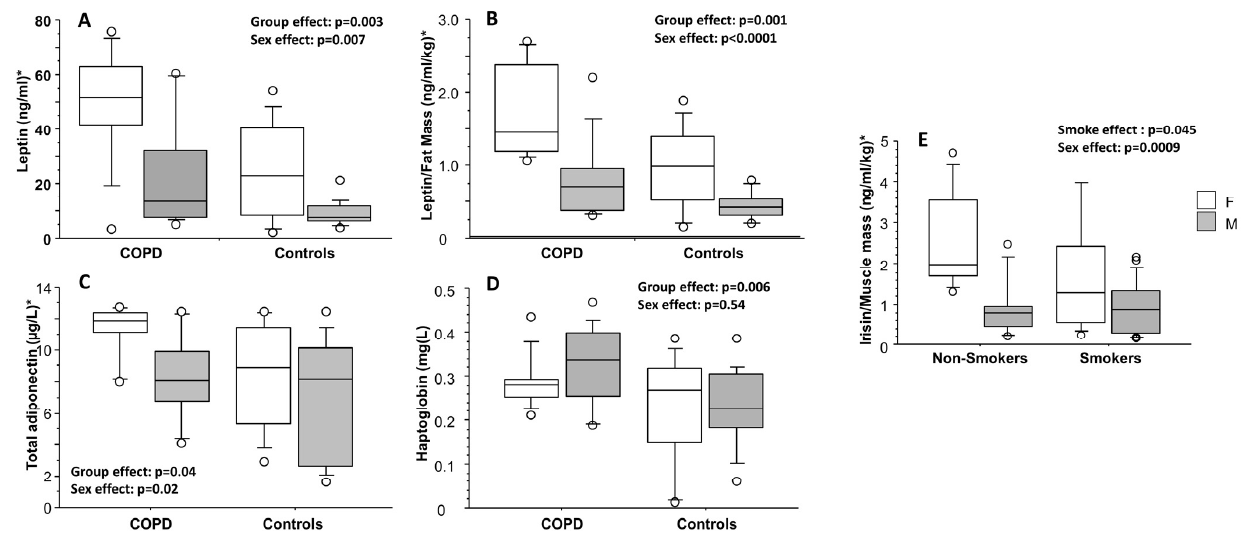
Figure 3. Leptin ( A ), leptin/fat mass ratio ( B ), total adiponectin ( C ), and haptoglobin ( D ) values, separately for COPD and control groups and sex. Irisin/muscle mass ratio ( E ), separately for smoking habit and sex. Results from two-way analysis of variance. For each box plot, from the bottom to the top, horizontal lines display the 10th, 25th, 50th (median), 75th, and 90th percentiles of the values. Values below 10th percentile and above 90th percentile are plotted as circles. * Leptin, leptin/fat mass ratio, total adiponectin, and irisin/muscle mass values were normalized by mean and standard deviation.